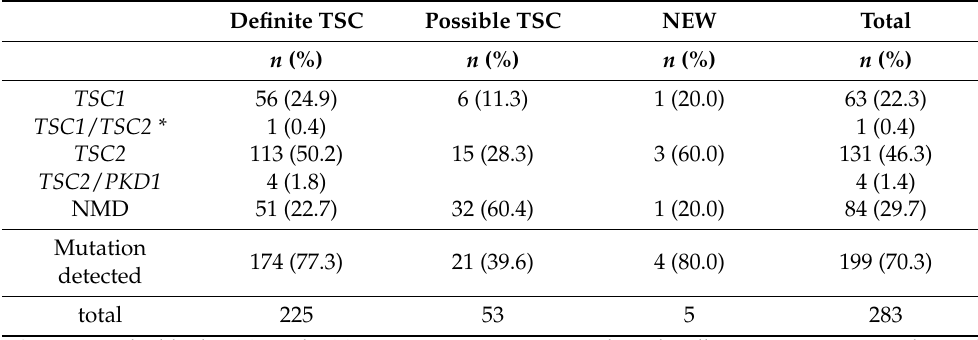
Table 3. Mutation detection rate.